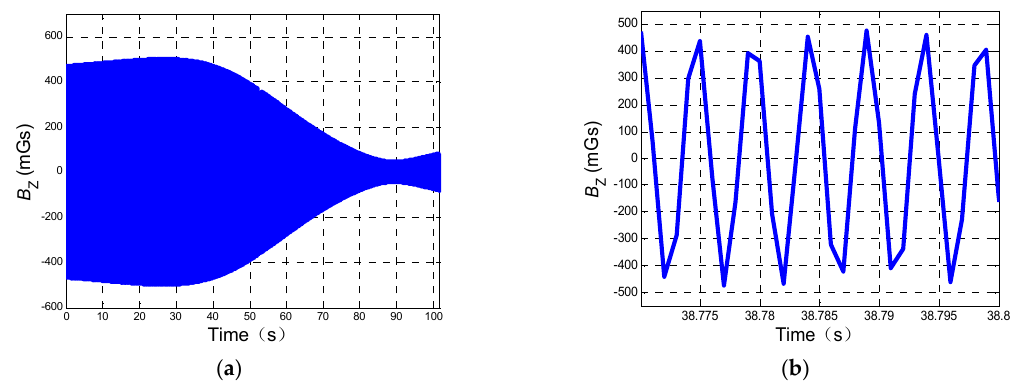
B changing in flight: ( a ) Description of the amplitude of Figure 11. Amplitude of Figure 11. Amplitude of B Z changing in flight: ( a ) Description of the amplitude of B Z . ( b ) Description Z of part of the amplitude of B Z (within 0.03 second). B (within 0.03 second). Description of part of the amplitude of Z